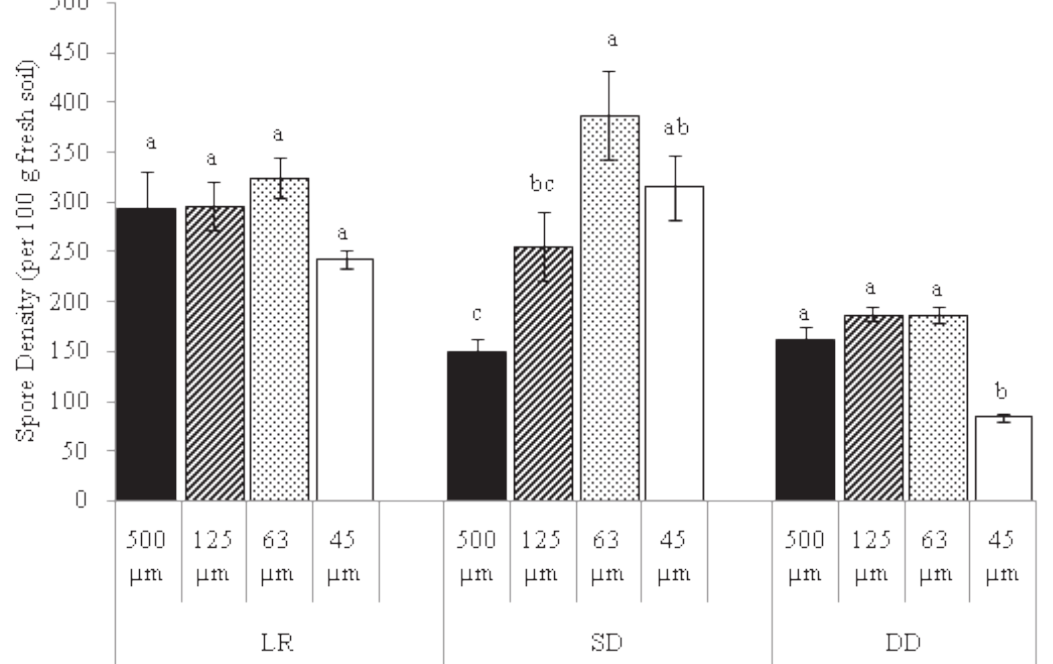
Figure 2: Density of arbuscular mycorrhizal fungal (AMF) spores (per 100 g fresh soil) under 4 size categories (500, 125, 63 and 45 µm in natural forest (LR), shrub-dominated site (SD) and Dicranopteris dominated fernland (DD) at Kanneliya Forest Reserve, Sri Lanka. Each bar represents an average of 10 soil samples. Vertical bars represent the standard error of means (SEM). The different letters indicate significant differences between means of different size categories in each land use type separately. The results were presented separately for the three land use types for more clarity. ANOVA: LR, F = 1.89, p = 0.149; SD = F = 9.25, p = 0.000 and DD, F = 29.99, p = 0.000.